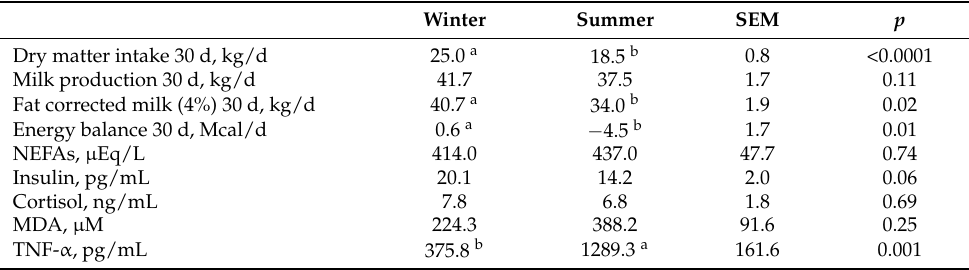
Table 1. Dry matter intake, milk production, and energy balance during the first month postpartum (PP), and plasma concentrations of metabolic and stress indicators during the peripartum period in cows calving during winter or summer.